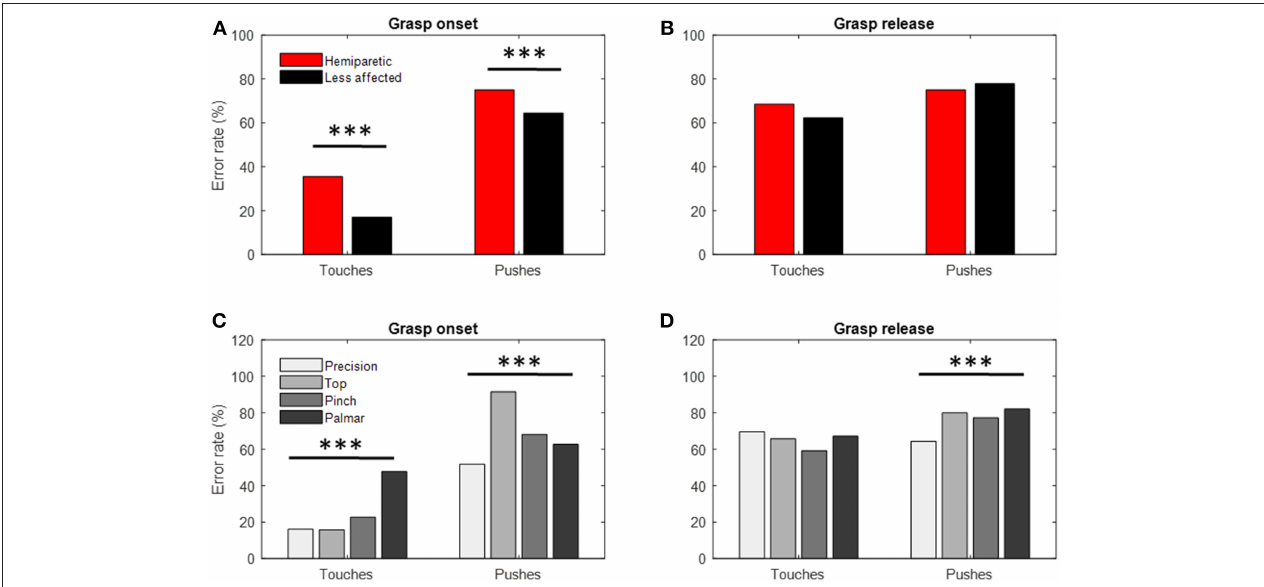
FIGURE 7 | Frequency of touch and push errors. (A) Frequency of touch and push errors made at grasp onset by the hemiparetic (red) and less affected (black) arms. (B) Same data distributed according to the different types of grasps used. (C) Frequency of touch and push errors made at grasp release by the hemiparetic (red) and less affected (black) arms. (D) Same data distributed according to the different types of grasps used. ***Chi-squared test p <